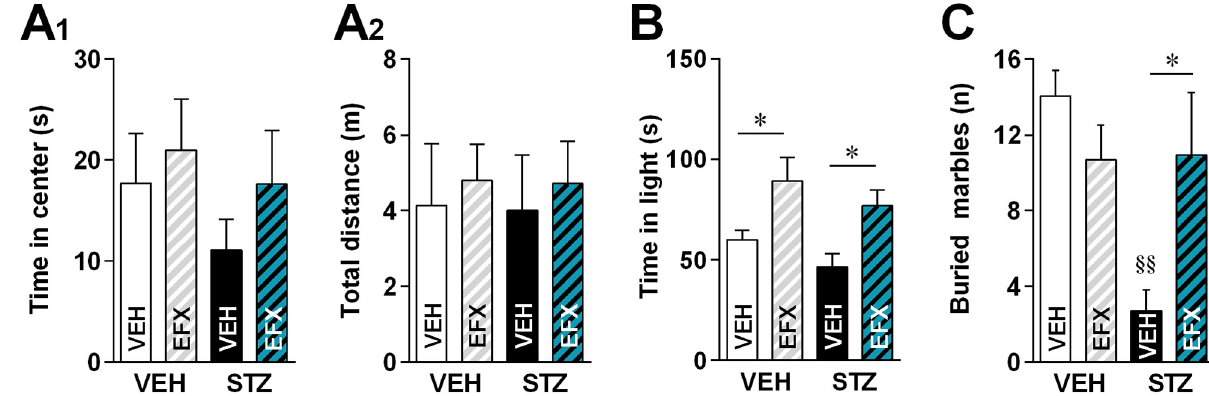
Fig 2. Effect of etifoxine on anxiety-like symptoms following STZ-induced diabetic neuropathy. A. Time spent in the center of an open field (A 1 ; n = 10–14 per group) and total distance travelled in the open field (A 2 ). B. Time spent in the light compartment of a light/dark box (n = 13–21 per group). C. Mean number of buried marbles (n = 7–8 per group). Statistical significance was assessed with Tukey’s multiple comparison test, illustrated as follows: p < 0.05 ( � ) for intra-group comparisons (VEH vs EFX treatment) and p < 0.01 (§§) for inter-group comparisons (VEH or EFX).